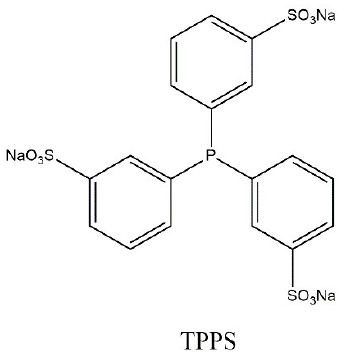
Figure 10. Simplified formula of sodium salt (tris(3-sulfonylphenyl)phosphine).